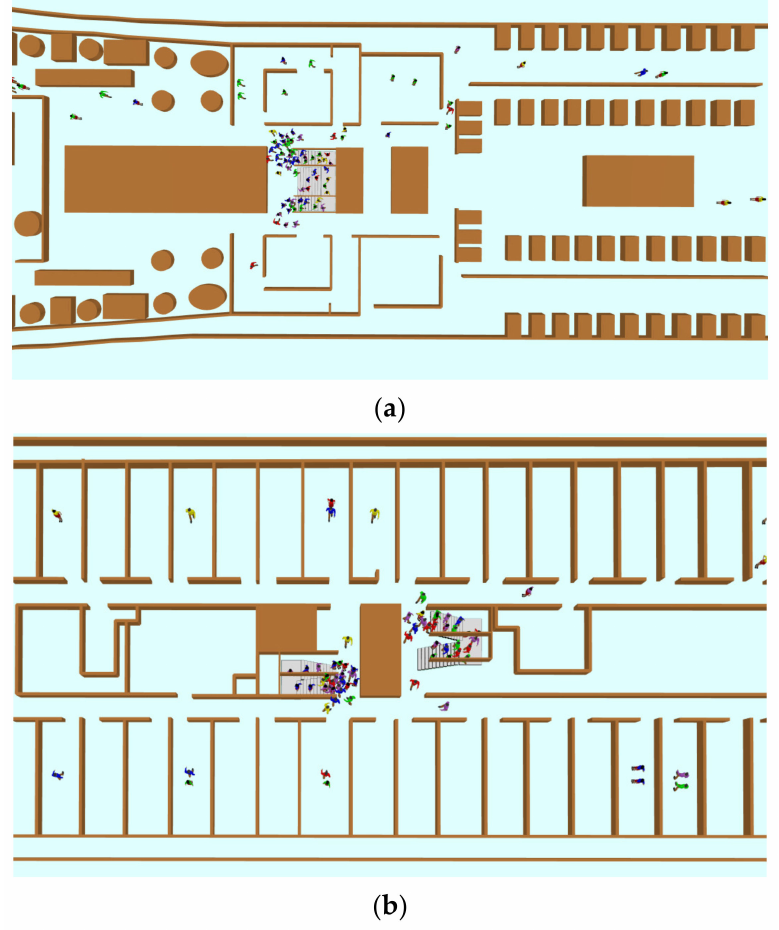
Figure 10. The snapshots of the evacuation simulation. ( a ) Deck 7; ( b ) Deck 3.